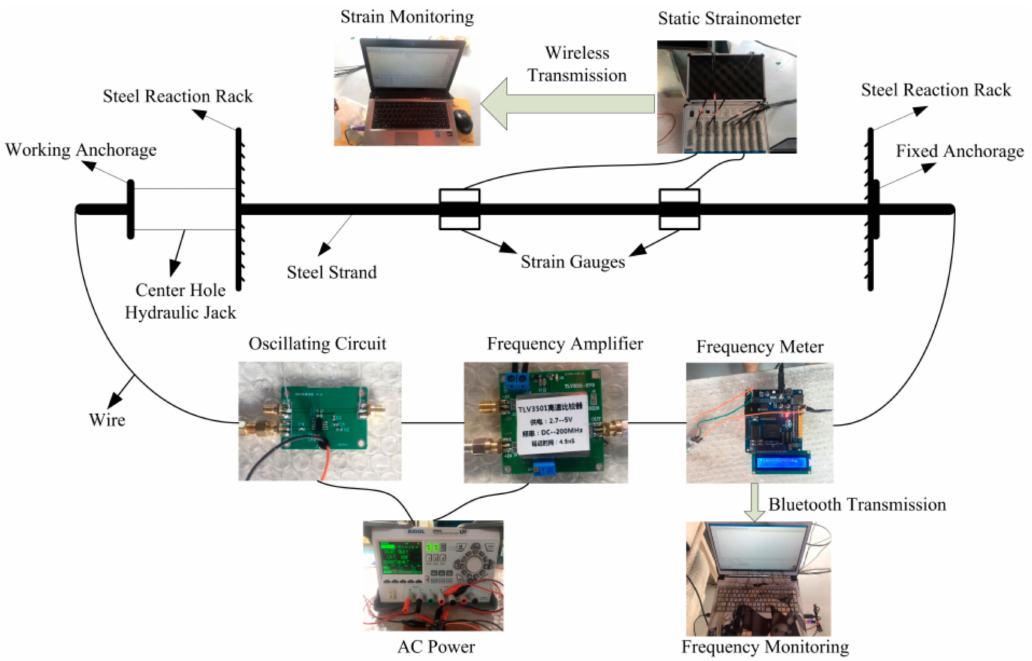
Figure 7. The experimental system of long steel